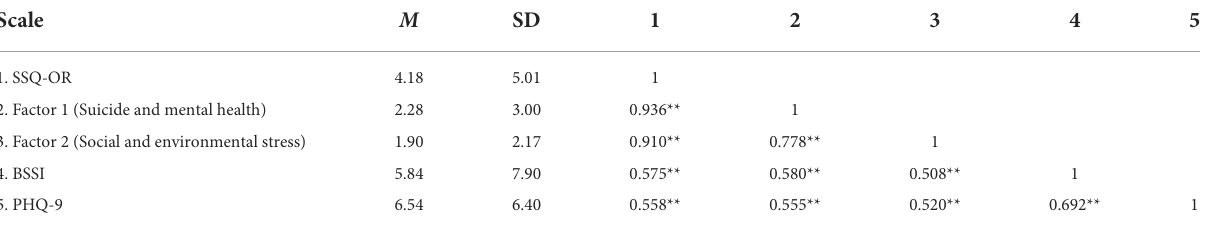
TABLE 2 Means, standard deviations, and scale inter correlations.